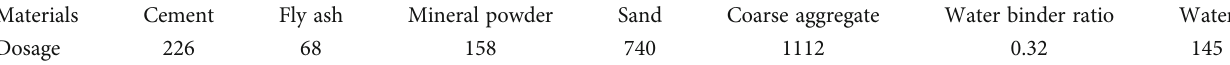
Table 1: The content of di ff erent admixture concrete